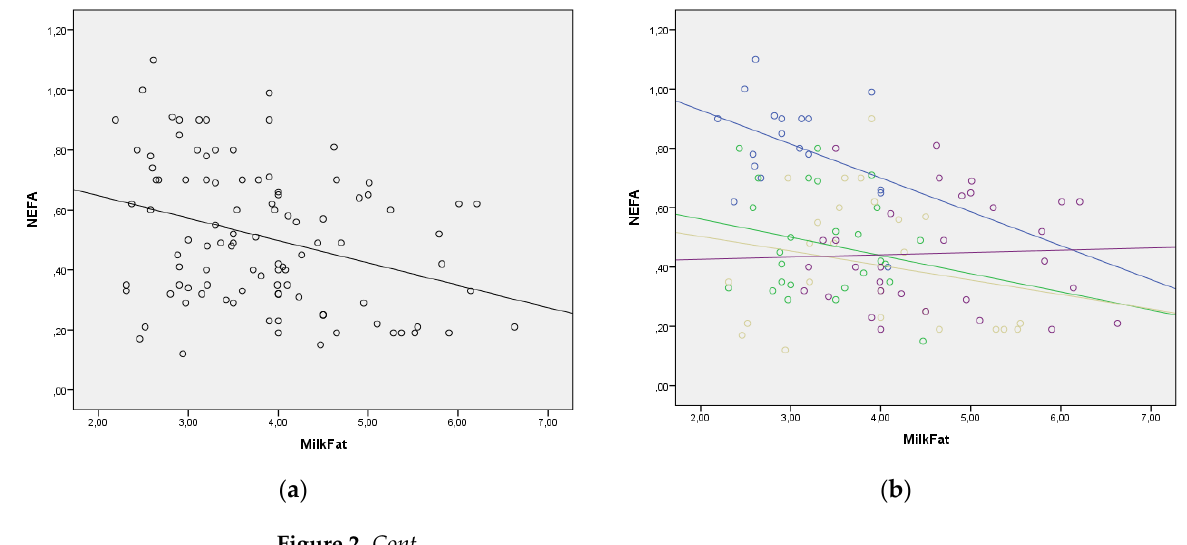
The regression lines for the statistically significant correlations between blood NEFA and BHB levels and selected milk parameters are presented in Figs. 2. The regression lines for milk fat to blood BHB, milk fat to blood NEFA, and milk BHB to blood